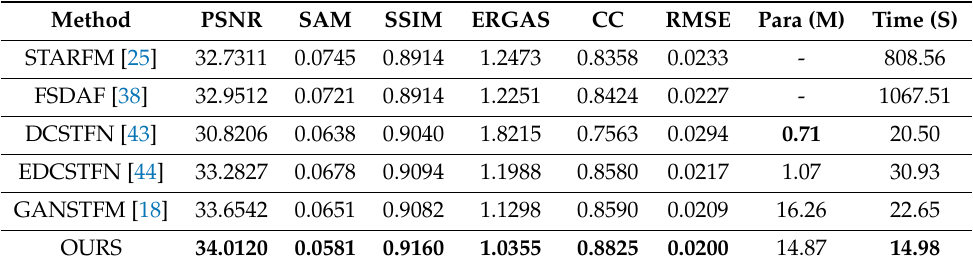
Table 5. compares MCBAM-GAN with some of the most advanced models in the CIA dataset. The values in bold are the best